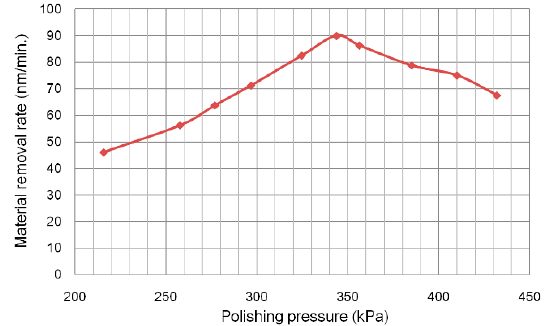
Figure 9. Material removal rate (MRR) change as a function of polishing pressure.